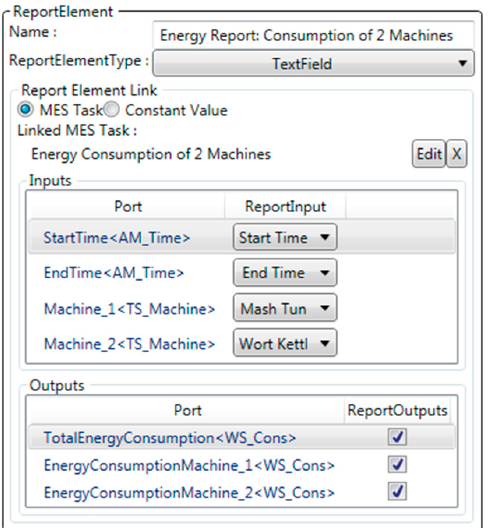
Figure 13. Element in the report model related to the MES function for calculating the energy consumption.